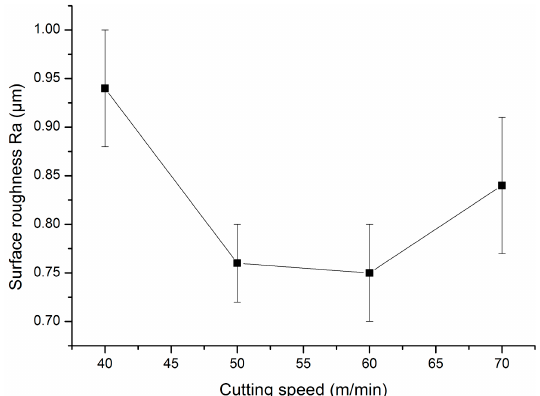
Figure 18. Evolution of surface roughness against cutting time at different cutting speeds (feed rate of 0.1 mm/r, depth of cut of 1.0 mm).